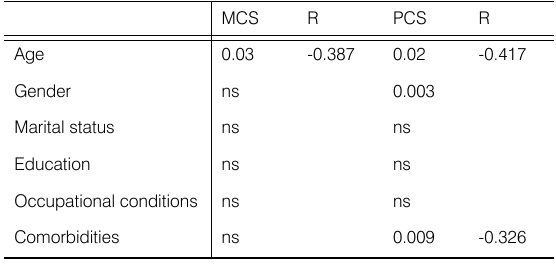
Table 5. Correlations between the PCS (Physical Component Scale) score, the MCS (Mental Component Scale) score and so- ciodemographic data (p-value, R-Spearman coefficient if statistically significant) in control group (ns-statistically non-